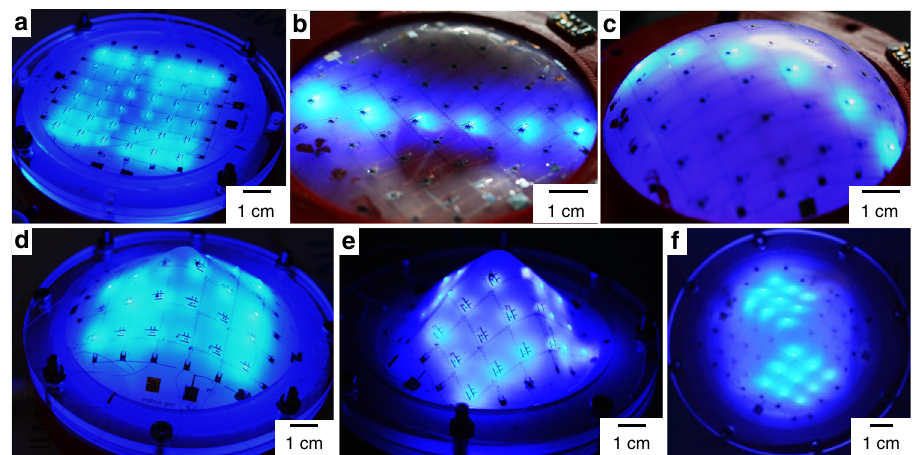
Fig. 4 Deformable LED active matrix realized using SPCB method. The planar a addressable LED matrix can be deformed to different shapes without altering its electrical functionality. The deformation involves de fl ation ( b ), in fl ation ( c ), 3D guided shapes ( d ), and vacuum forming ( e ). The addressability of the array remains unaltered after mechanical deformation ( f